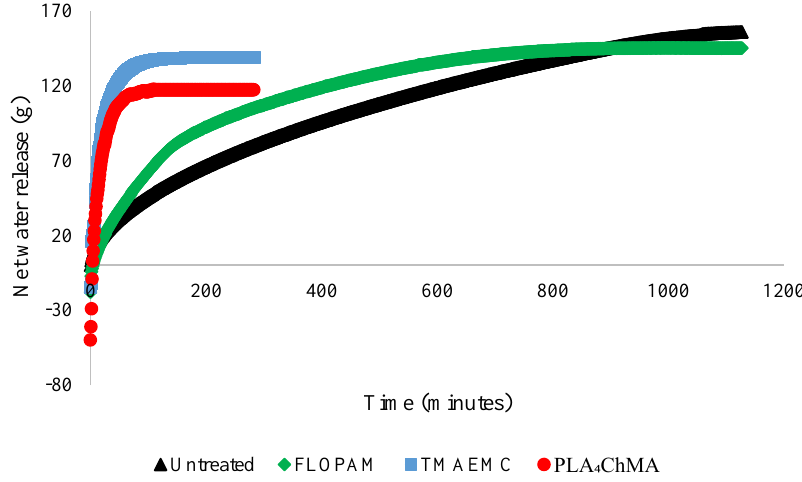
Figure 6. Net water release over time during filtration following flocculation with FLOPAM (1500 ppm), poly(TMAEMC) (10,000 ppm), and poly(PLA 4 ChMA) (20,000 ppm). Table 1. Summary of net water releases and cake compactions from filtration experiments. TMAEMC: trimethylaminoethyl methacrylate chloride.